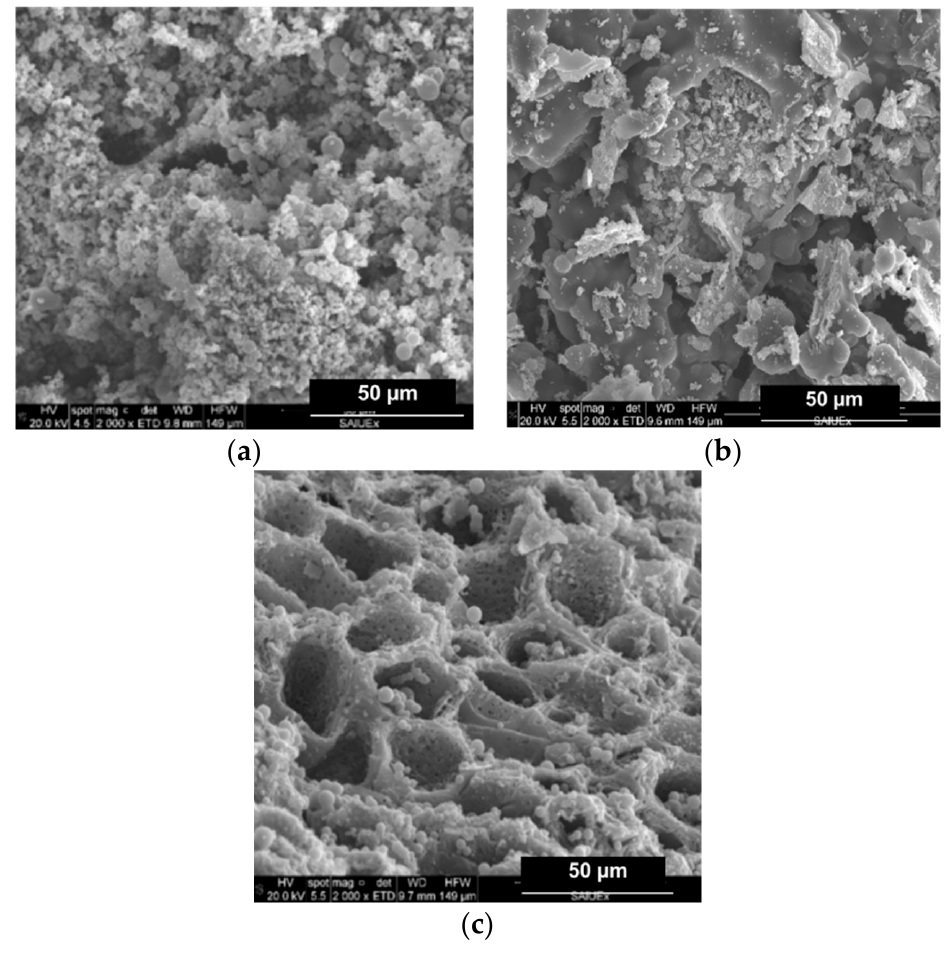
Figure 3. SEM micrographies of ( a ) CA – HC, ( b ) CA – HC – Fe, and ( c ) CA – HC – Fe 3 -600.